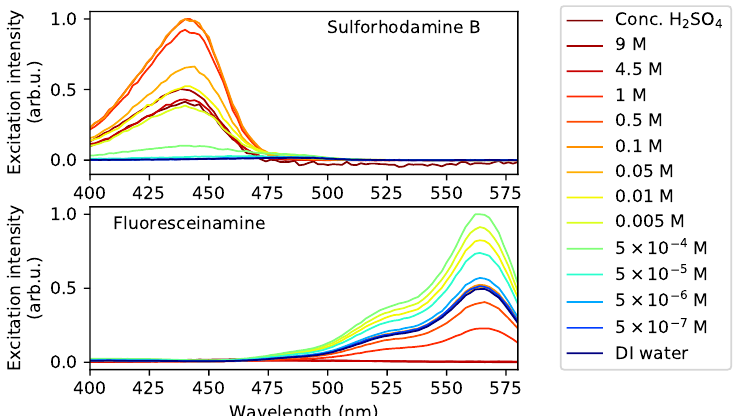
Figure 8. Fluoresceinamine and sulforhodamine B excitation spectra in H 2 SO 4